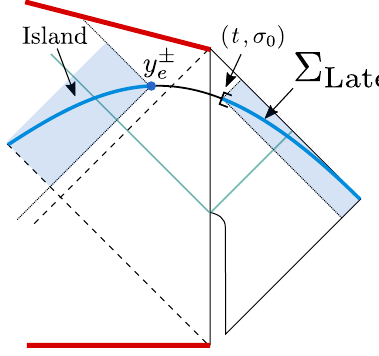
Figure 7 . Spacetime diagram for the formation and evaporation of the black hole. We consider the entanglement wedges of the radiation. The \island" is the left wedge, which is disconnected from the right